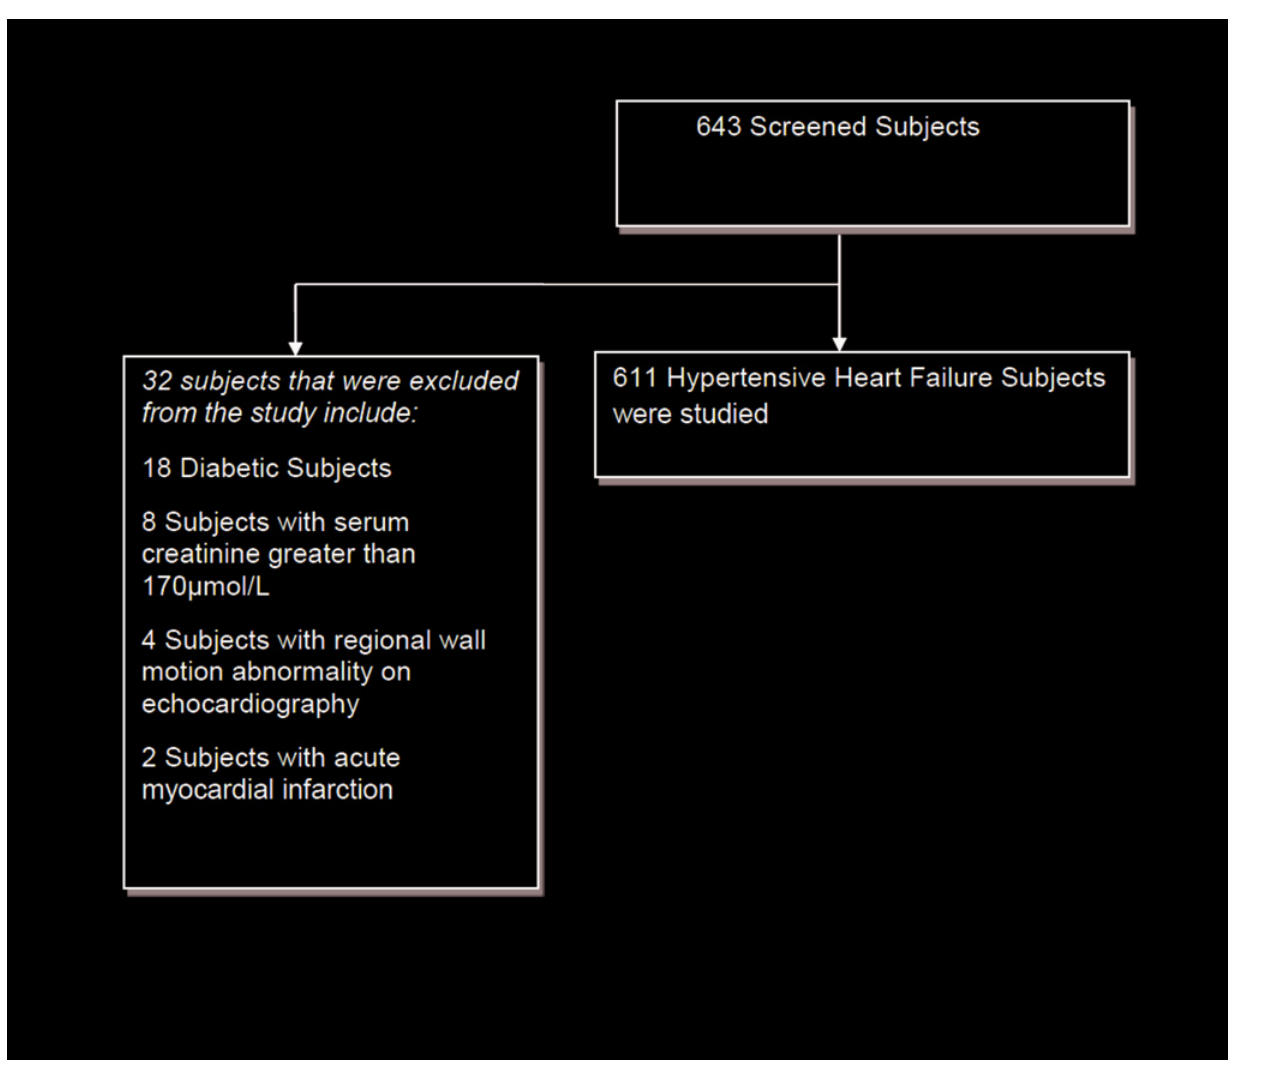
Fig 1. Algorithm of recruitment and enrolment of